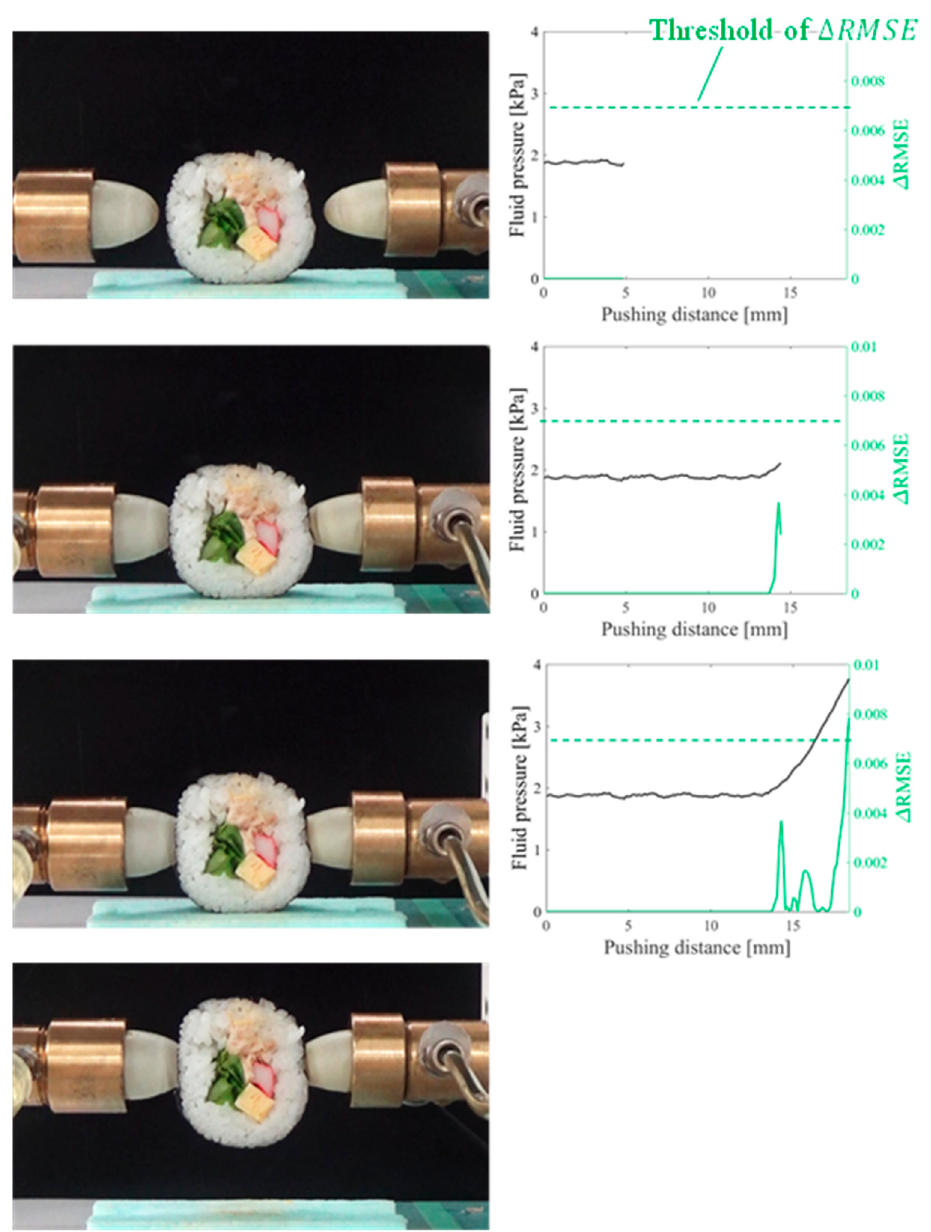
Figure 11. Overview of the grasping test (sushi target)